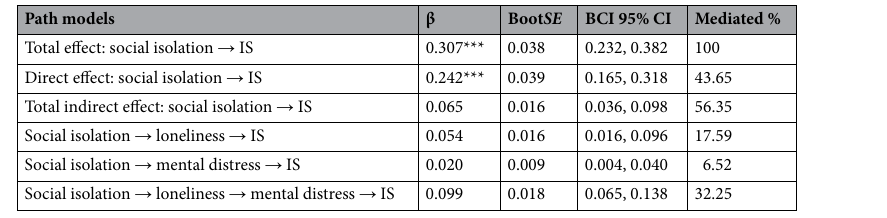
Table 4. The indirect effects of social isolation on IS through loneliness and mental distress as mediators ( N = 1201). Models were adjusted for age, sex, residential status, marital status, level of education, employment status, physical activity, and multimorbidity. Empirical 95% confidence interval does not overlap with zero. β Unstandardized regression coefficients are reported; BootSE bootstrapping standard error; IS impaired sleep. *** p ˂